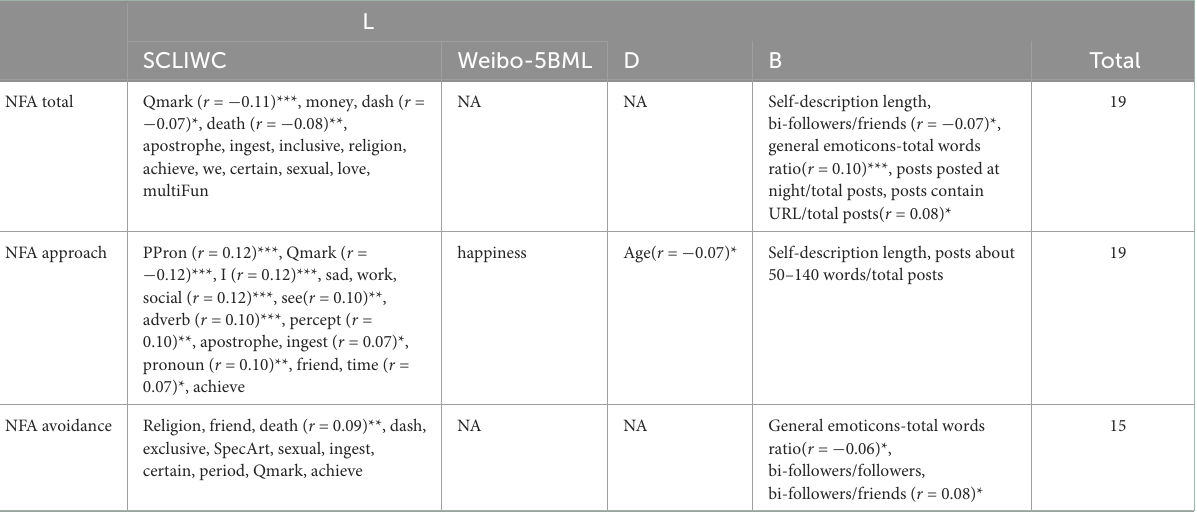
TABLE 4 Selected features for